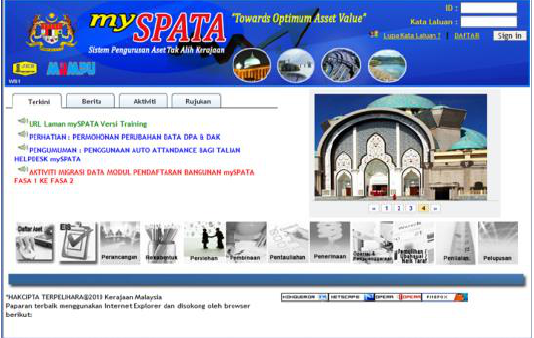
Figure 6 : The interface of MySPATA (Source: MySPATA Manual Guide)